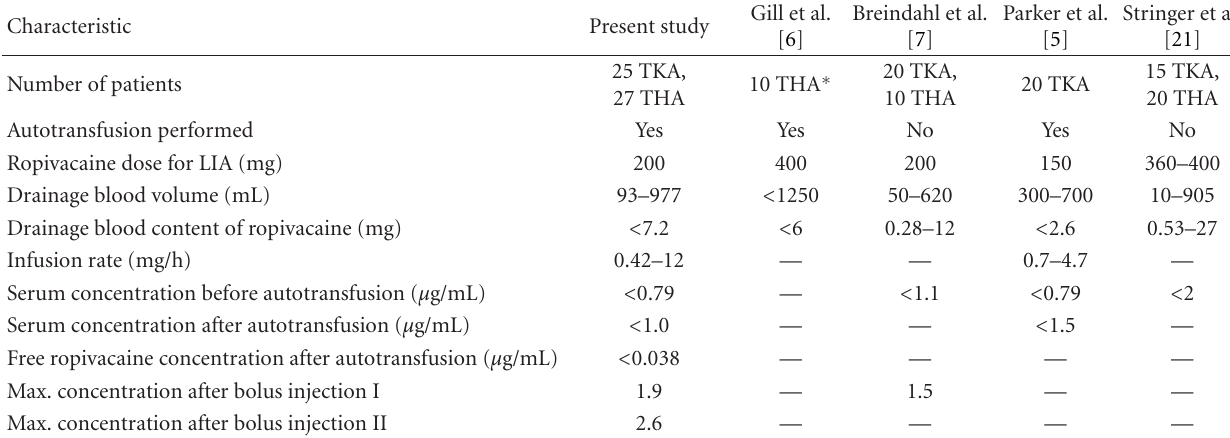
Table 2: Comparison of studies in autotransfusion after LIA with ropivacaine.